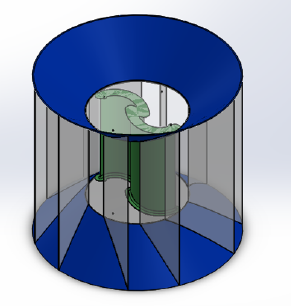
Figure A1. Model loaded in